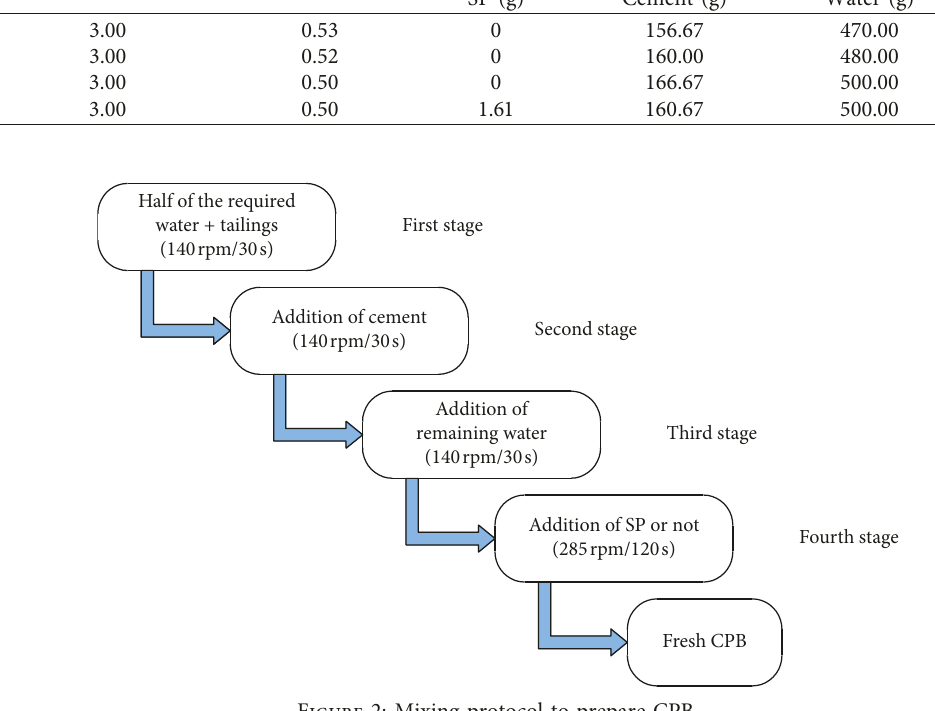
Figure 2: Mixing protocol to prepare CPB.